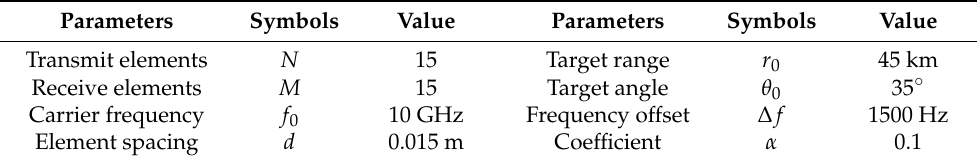
Table 1. Simulation